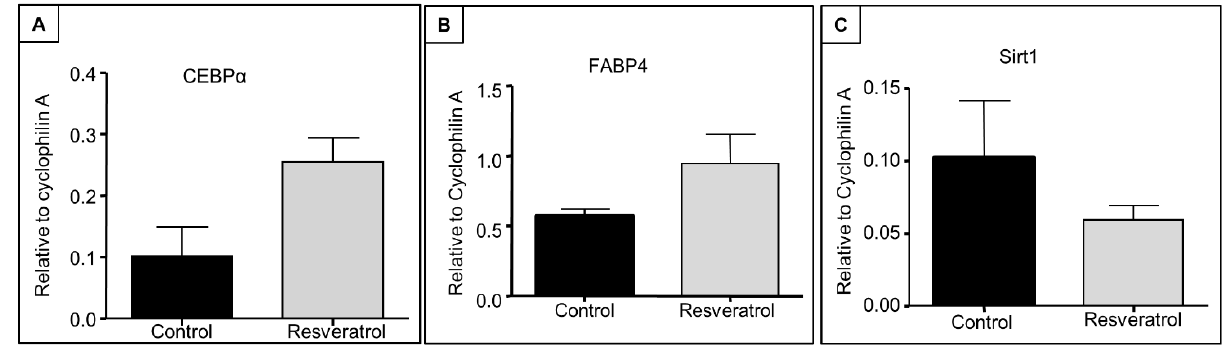
Figure 4. Effects of resveratrol supplementation on mRNA expression levels of adipogenesis-related factors and Sirtuin 1 (Sirt1) in early ageing rats. RT-PCR gene expression analyses at tibial metaphysis for ( A ) C/EBPα ( p = 0.06); ( B ) FABP4 ( p = 0.34) and ( C ) Sirt1 ( p = 0.36) ( n = 7). C/EBPα, CCAAT/enhancer-binding protein alpha; FABP4, fatty acid-binding protein 4.